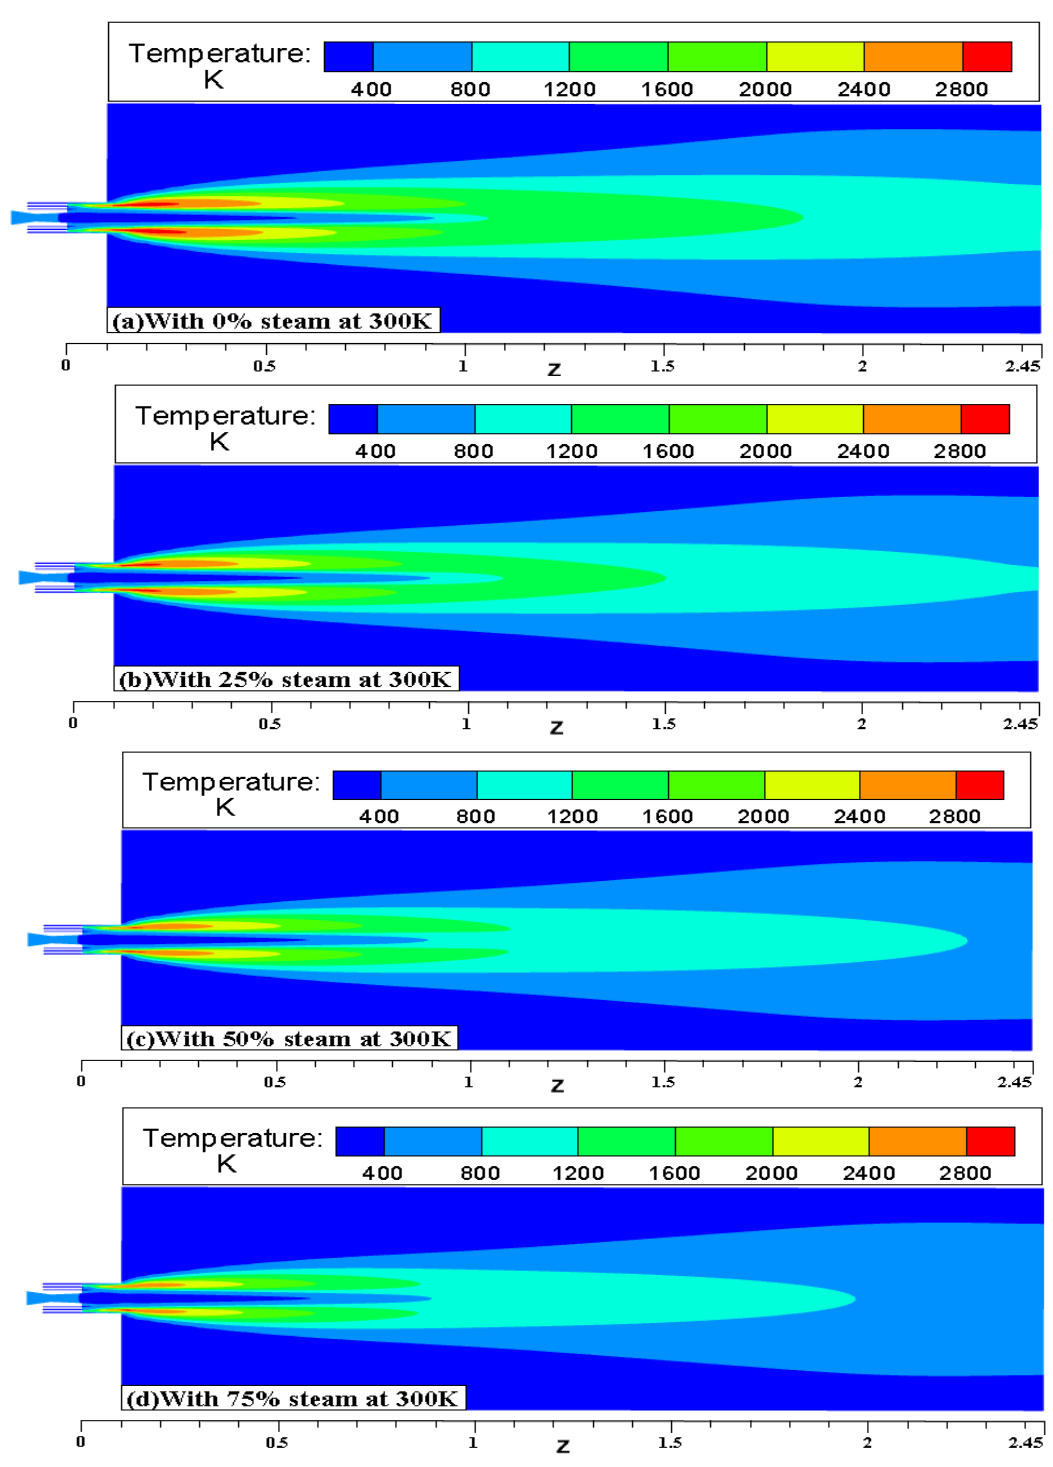
Figure 10. Total temperature distributions of the H 2 O and O 2 mixed jets in the longitudinal section at an ambient temperature of 300 K under various conditions: ( a ) 0% steam and 100% oxygen; ( b ) 25% steam and 75% oxygen; ( c ) 50% steam and 50% oxygen; and ( d ) 75% steam and 25% oxygen.